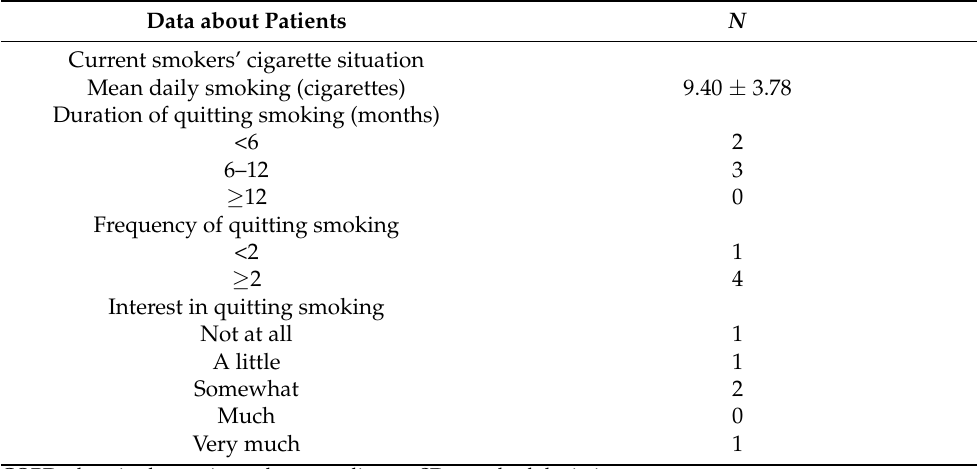
Table 3. Descriptive statistics of patients and healthcare professionals (HCPs).